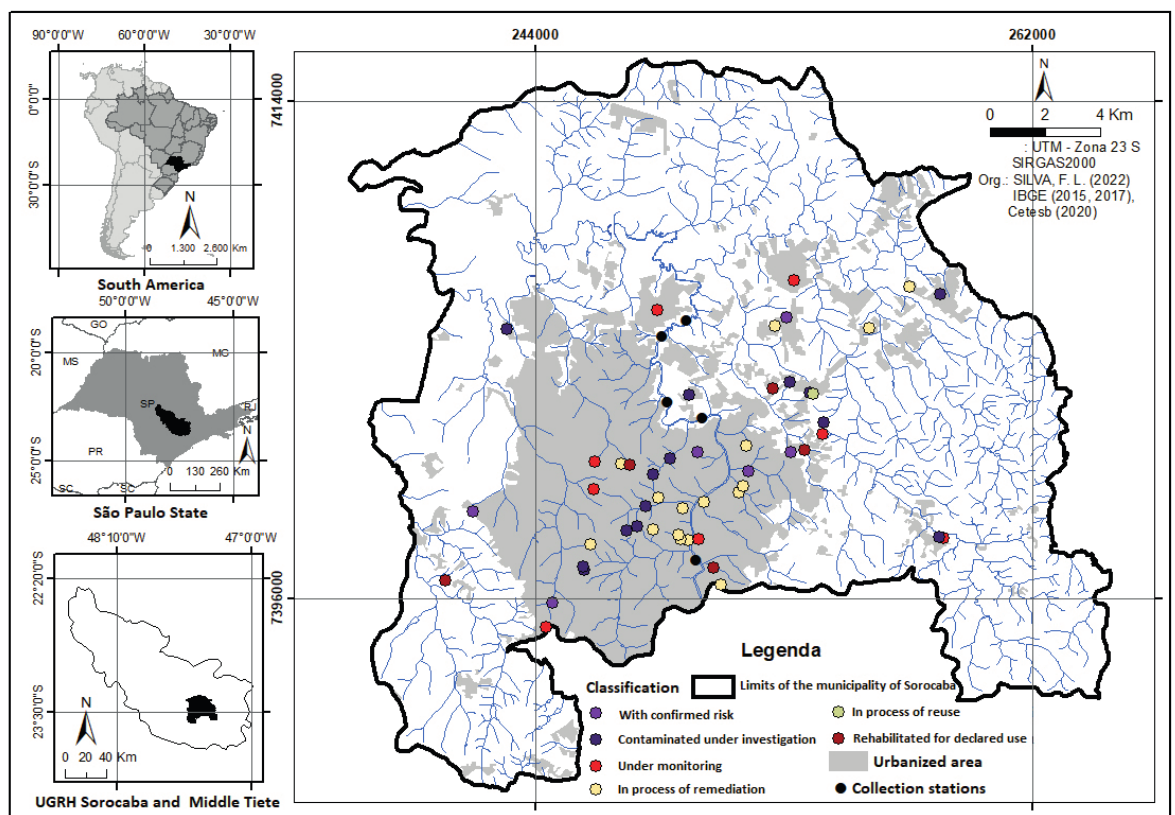
FIGURE 1 | Location of the study area in the Sorocaba River drainage, São Paulo State, Brazil, indicating the Sorocaba river, the fish collection points, in addition to the urban area and areas of